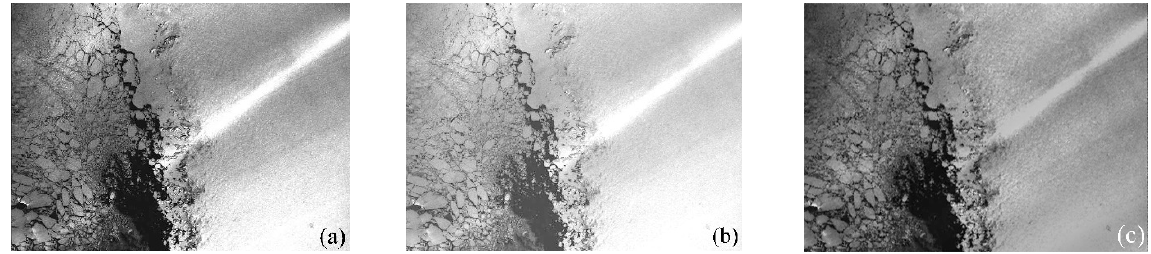
Figure 17. Comparing the result by different methods. ( a ) Original image. ( b ) Result by brightness stretch [1]. ( c ) Result by brightness compensation method.